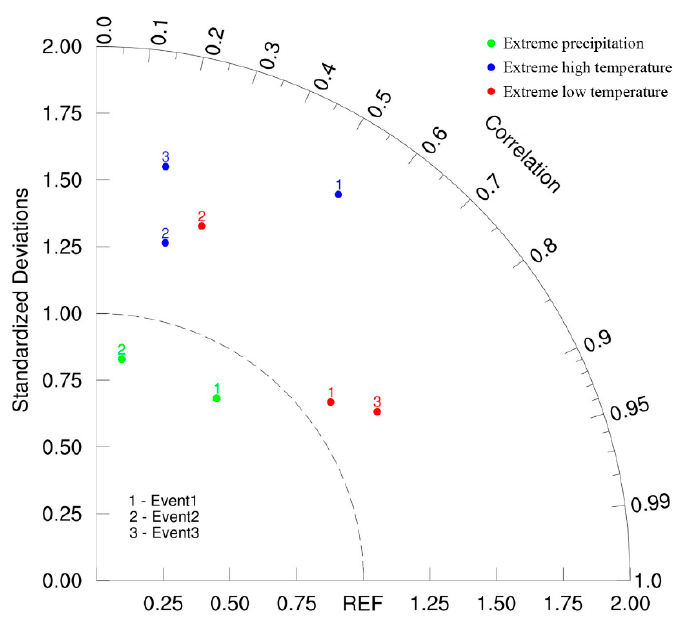
Figure 12. Taylor diagram of nine extreme events over Northwest China during